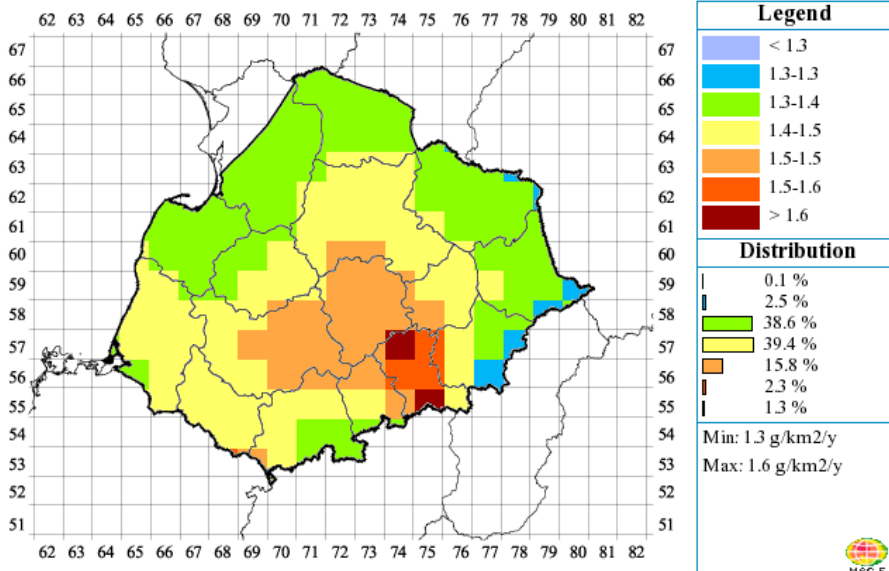
Figure 2. Annual mean concentrations of atmospheric Hg [ng m − 3 ] in Poland for 2015 over the EMEP domain (Meteorological Synthesizing Centre-East, 2017; Supplement to EMEP Status Reports 2/2017 and 3/2017 “Heavy metal and POP transboundary pollution in 2015: Concentration and deposition maps, source-receptor matrices, ecosystem-specific deposition and evaluation of model performance”; http://en.msceast.org/index.php/pollution-assessment/emep-domain-menu).